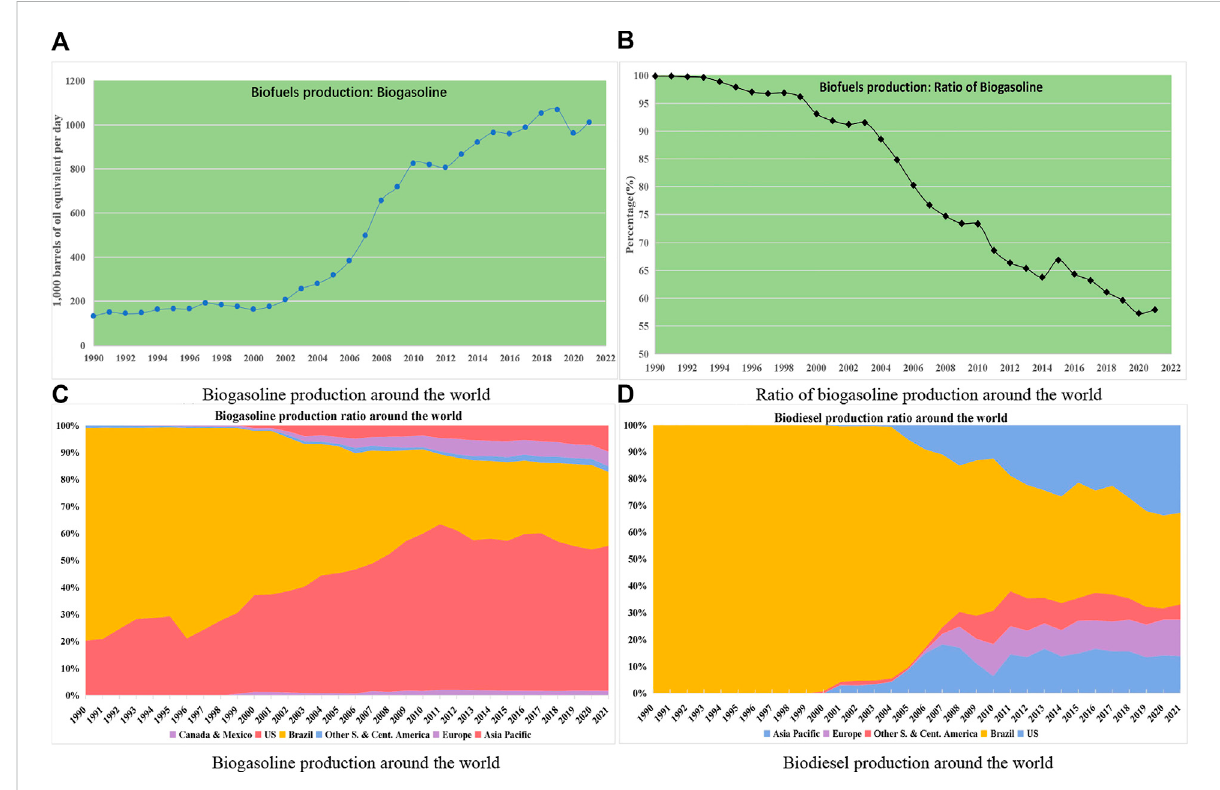
FIGURE 1 Statisticaldataofbio-fuelproduction. (A) Bio-gasolineproductionaroundtheworld. (B) Ratioofbio-gasolineproductionaroundtheworld. (C) Biogasoline production ratio by regions around the world. (D) Biodiesel production ratio by regions around the